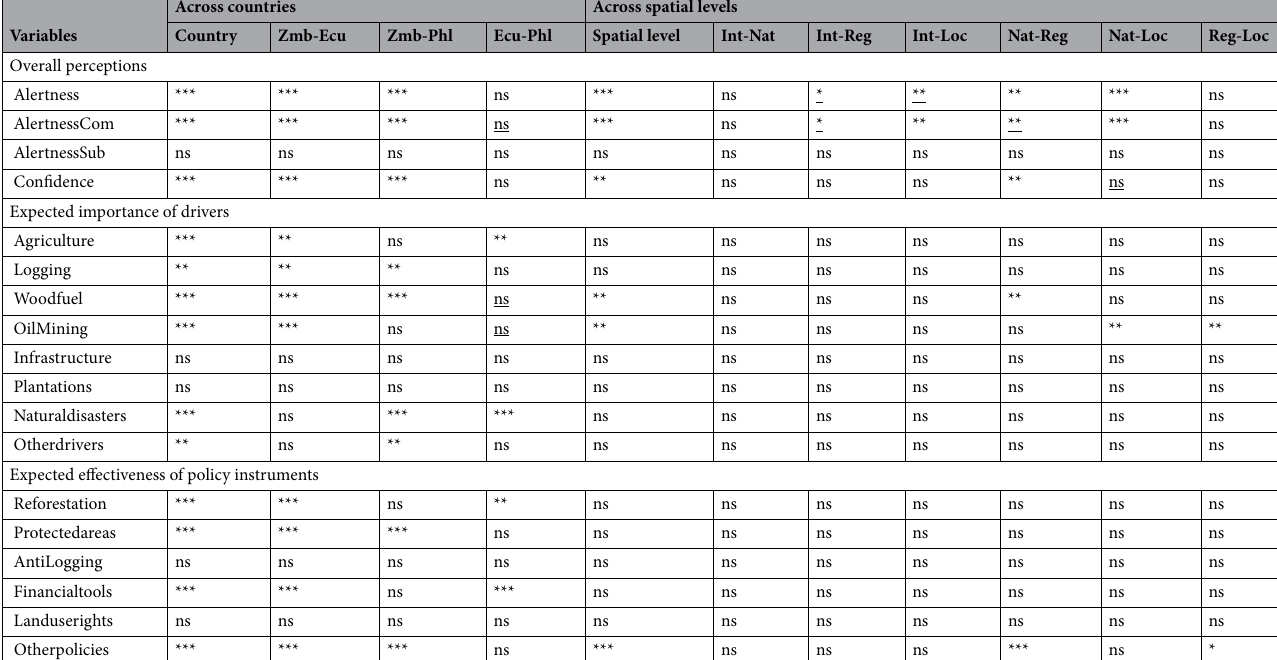
Table 3. Results of non-parametric ANOVAs for the eighteen studied variables, with overall cross-country and cross- ‘spatial level’ significances (***: < 0.001, **: < 0.01, *: < 0.05, ns not significant [> 0.05], underlined: disagreement between parametric and non-parametric methods) and results for group comparisons ( Zmb Zambia, Ecu Ecuador, Phl Philippines, Int International, Nat National, Reg Regional, Loc